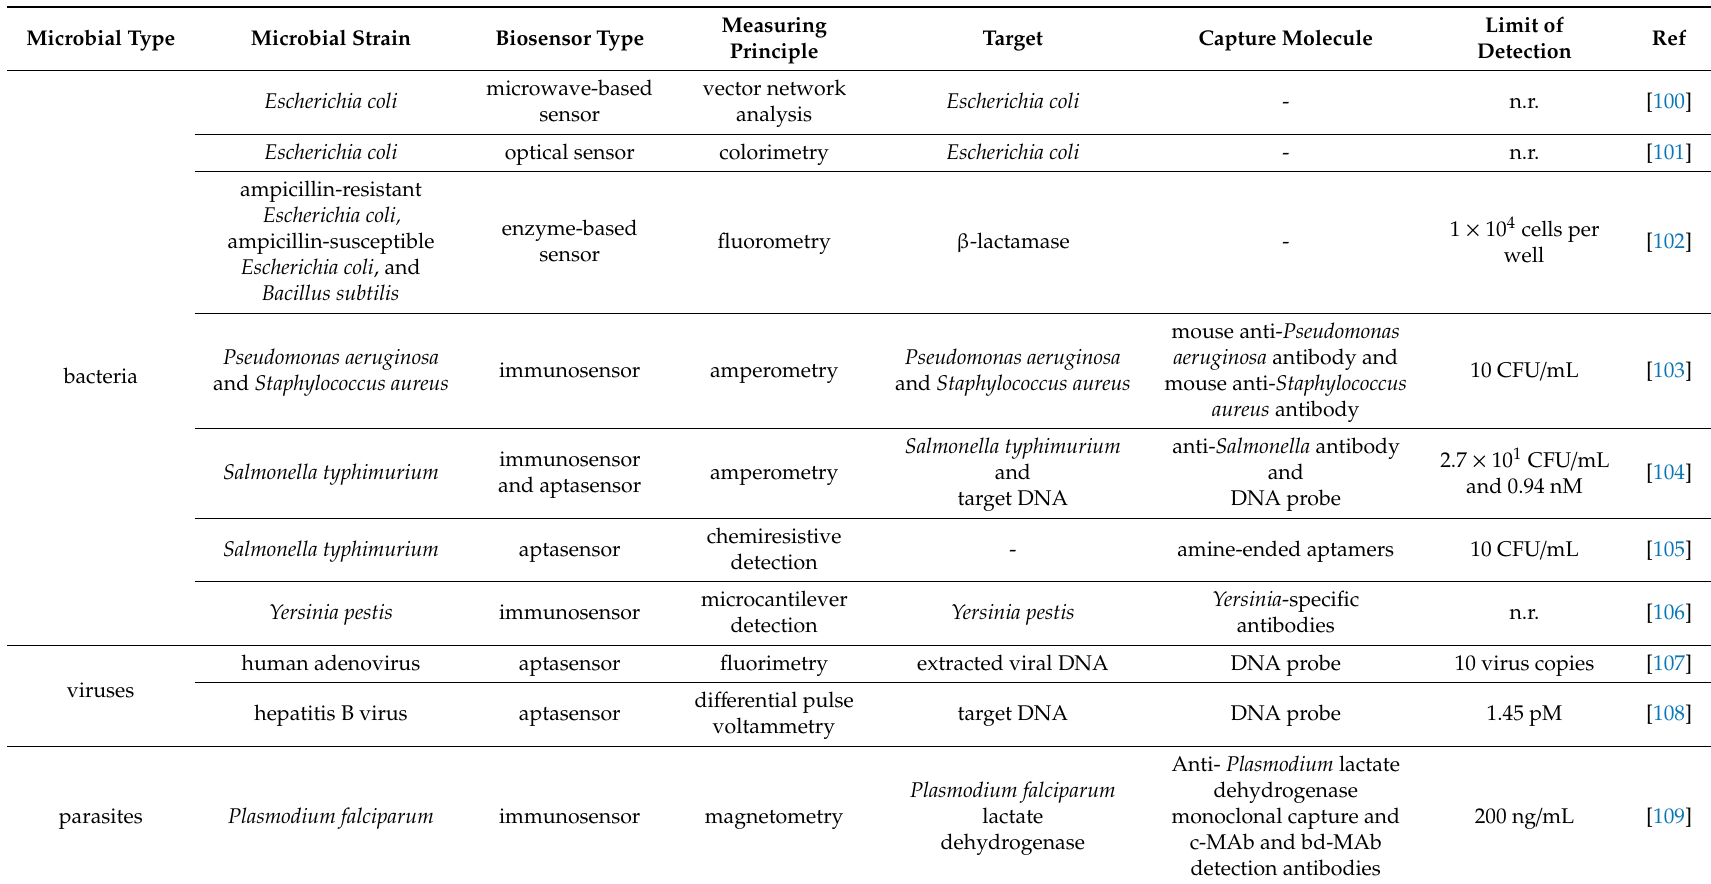
Table 2. A summary of the identified papers investigating the use of microfluidic biosensors for microbial infection